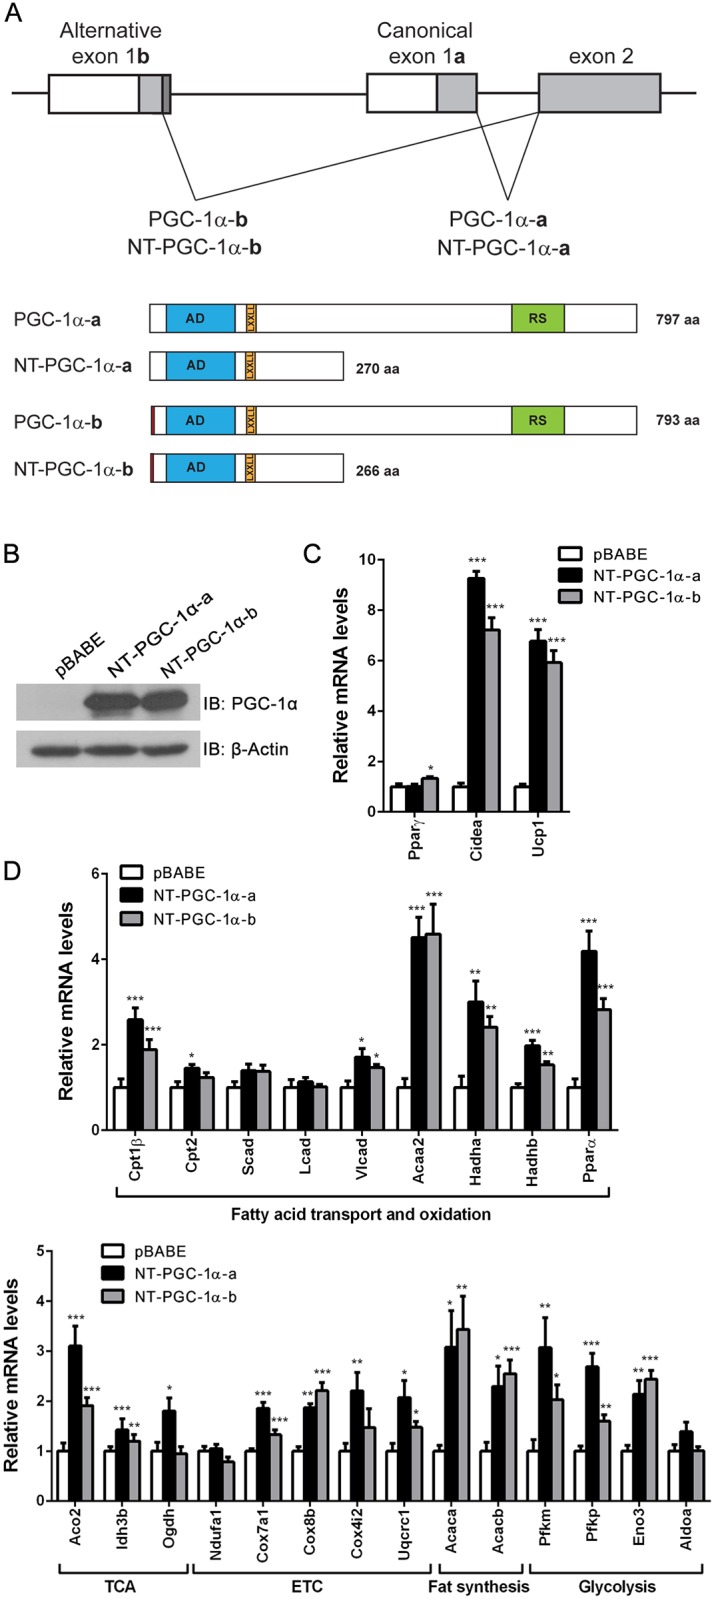
The effect of NT-PGC-1α on candidate gene expression in brown adipocytes.(A) Schematic diagram of splicing events of the PGC-1α gene. Splicing between canonical exon 1a and exon 2 produces PGC-1α-a and NT-PGC-1α-a, whereas alternative splicing between distal exon 1b and exon 2 produces PGC-1α-b and NT-PGC-1α-b. AD, transcription activation domain; LxxLL, nuclear receptor interaction motif; RS, arginine/serine-rich domain. (B) Expression of NT-PGC-1α-a and NT-PGC-1α-b proteins in PGC-1α-null brown adipocytes. (C) Quantitative real-time PCR analysis of gene expression in PGC-1α-null brown adipocytes expressing pBABE empty vector, NT-PGC-1α-a or NT-PGC-1α-b (n = 8). Empty vector vs NT-PGC-1α-a or NT-PGC-1α-b: *P < 0.05, **P < 0.01, ***P < 0.001.